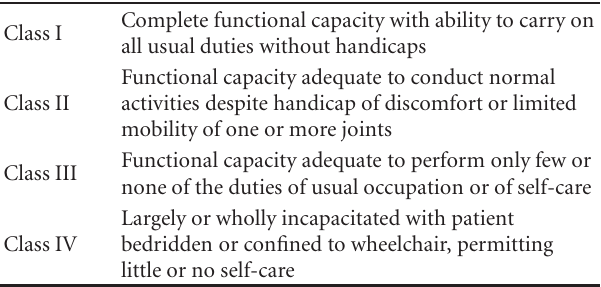
Table 1: Classification of functional capacity in rheumatoid arthri- tis Steinbrocker functional